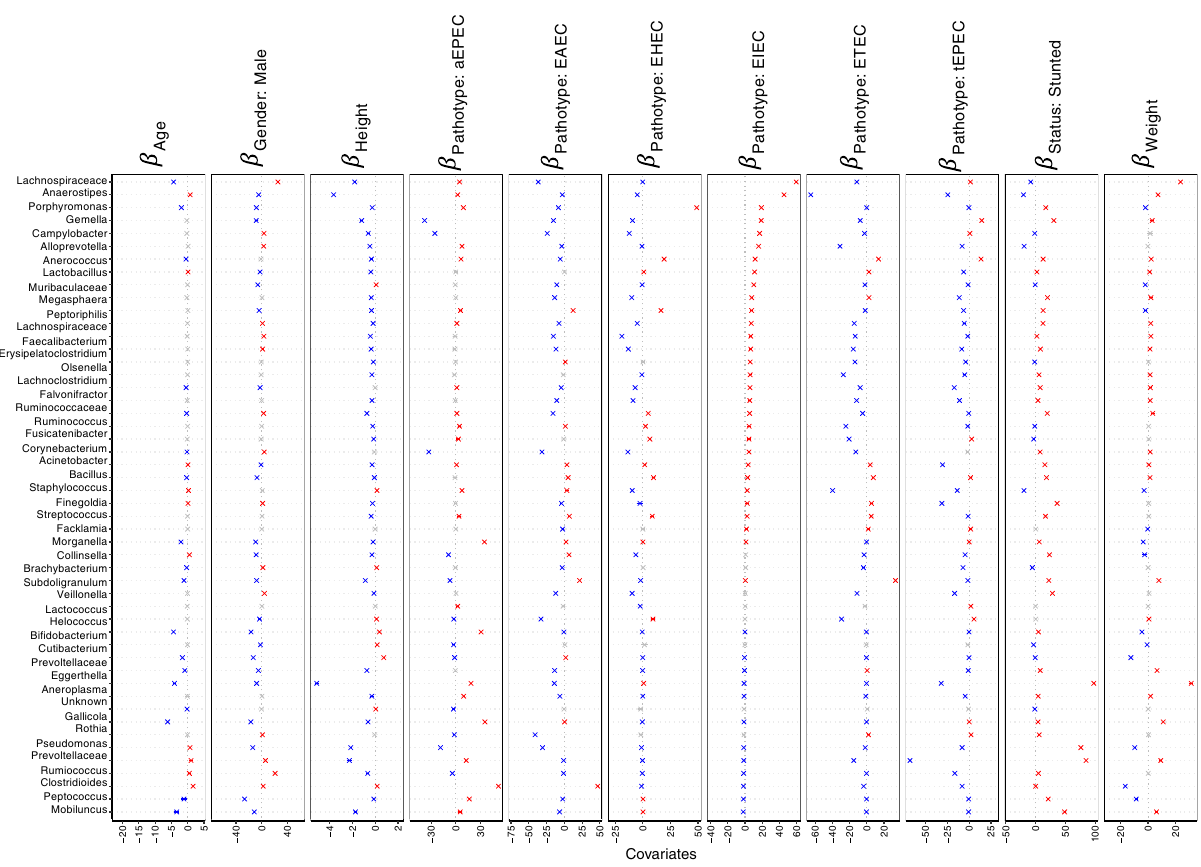
Figure 6. Beta-coefficients returned from the GLLVM procedure for covariates considered in this study by considering top 100 most abundant genera incorporating continuous data (Age, Height, and Weight) as well as categorical labelling of samples (Gender, Male, and Pathotypes). Those coefficients which are positively associated with the microbial abundance of a particular species are represented in red colour whilst those that are negatively associated are represented with blue colour, respectively. Where the 95% confidence interval of the beta-coefficients crosses the 0 boundary, i.e., they are insignificant, are represented by grey colour. Since the collation of the OTUs were done at Genus level, all those OTUs that cannot be categorized based on taxonomy are collated under “Unknown” category. The figure only shows beta-coefficients for 48 genera with the remaining ones shown in Fig.